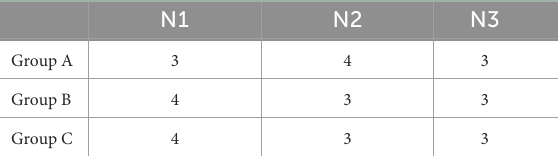
TABLE 1 Duration of chief complaint.